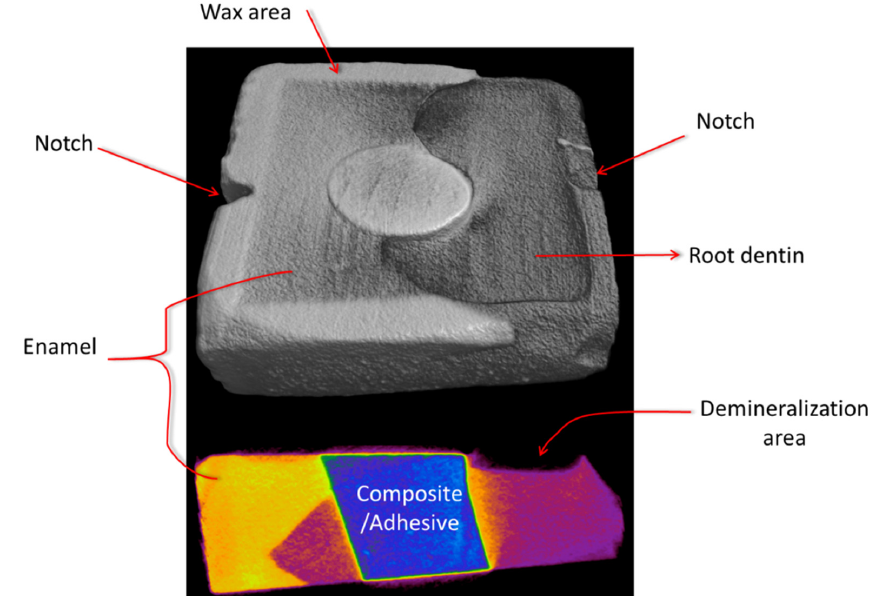
Figure 2. An example of 3D and 2D μ CT images in the anti-demineralization test. Two notches on the two side of tooth block act as landmarks for SS-OCT.